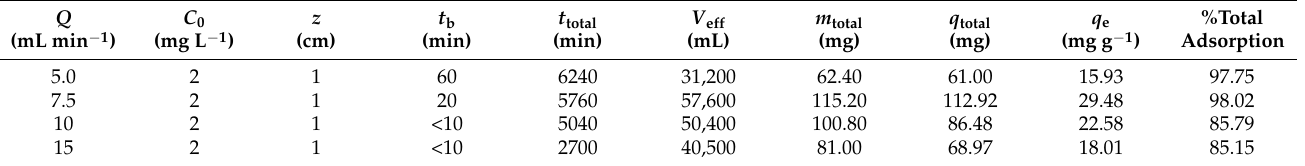
Figure 5. Breakthrough curves for phosphate adsorption onto monolithic Cry – CSH at different flow rates ( C t / C 0 is the ratio of effluent phosphate concentration at time t to the influent phosphate concentration). Table 1. Influence of the solution flow rate on experimental breakthrough parameters for phosphate adsorption by monolithic Cry – CSH.